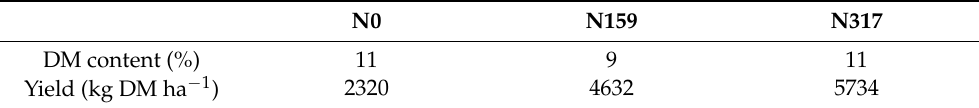
Table 5. Dry matter content (DM) (%) and yield (kg DM ha − 1 ) of Chinese cabbage plants.